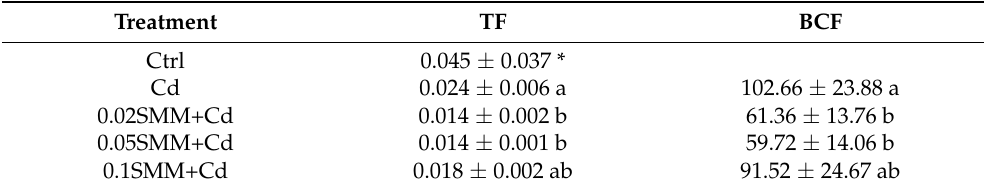
Figure 4. Cadmium concentration in the roots and shoots of Szarvasi-1 energy grass primed with 0.02, 0.05 and 0.1 mM SMM and exposed to 0.01 mM Cd. To compare the differences, one-way ANOVA was performed on each dataset combined with Tukey–Kramer post hoc test on the treatments ( p < 0.05). Different lowercase and uppercase letters indicate significantly different groups. Table 2. Translocation factor (TF) and bioconcentration factor (BCF) of Cd in Szarvasi-1 energy grass primed with 0.02, 0.05 and 0.1 mM SMM and exposed to 0.01 mM Cd. To compare the differences, one-way ANOVA was performed on each dataset combined with Tukey’s post hoc test on the treatments ( p < 0.05). Different lowercase letters indicate significantly different groups.